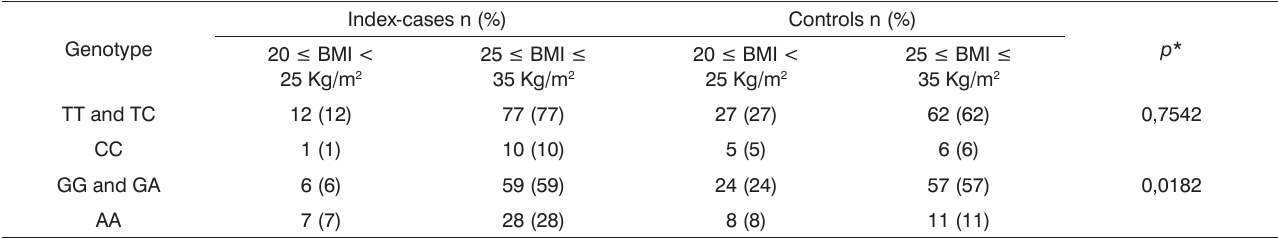
Table 6. Distribution of the BMI (body mass index) of index cases and controls relative to the genotypes for T102C and -1438G/A polymorphisms of the 5-HTR2A gene.